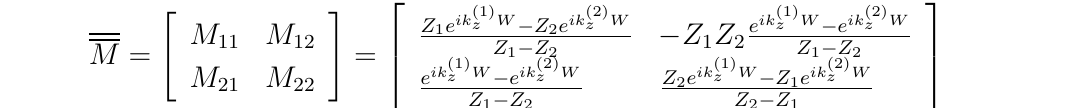
Figure 5. Real (blue) and imaginary (red) parts of k (2) ϕ = 44 ◦ , k = k sin θ, θ = 44 ◦ , (cid:15) x 0